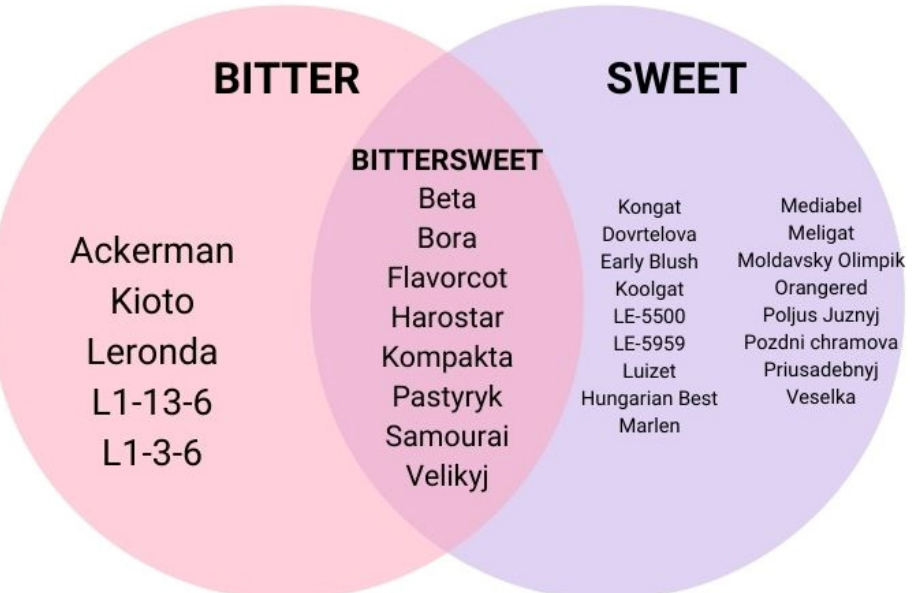
Figure 4. Variation of apricots cultivars based on taste [17].